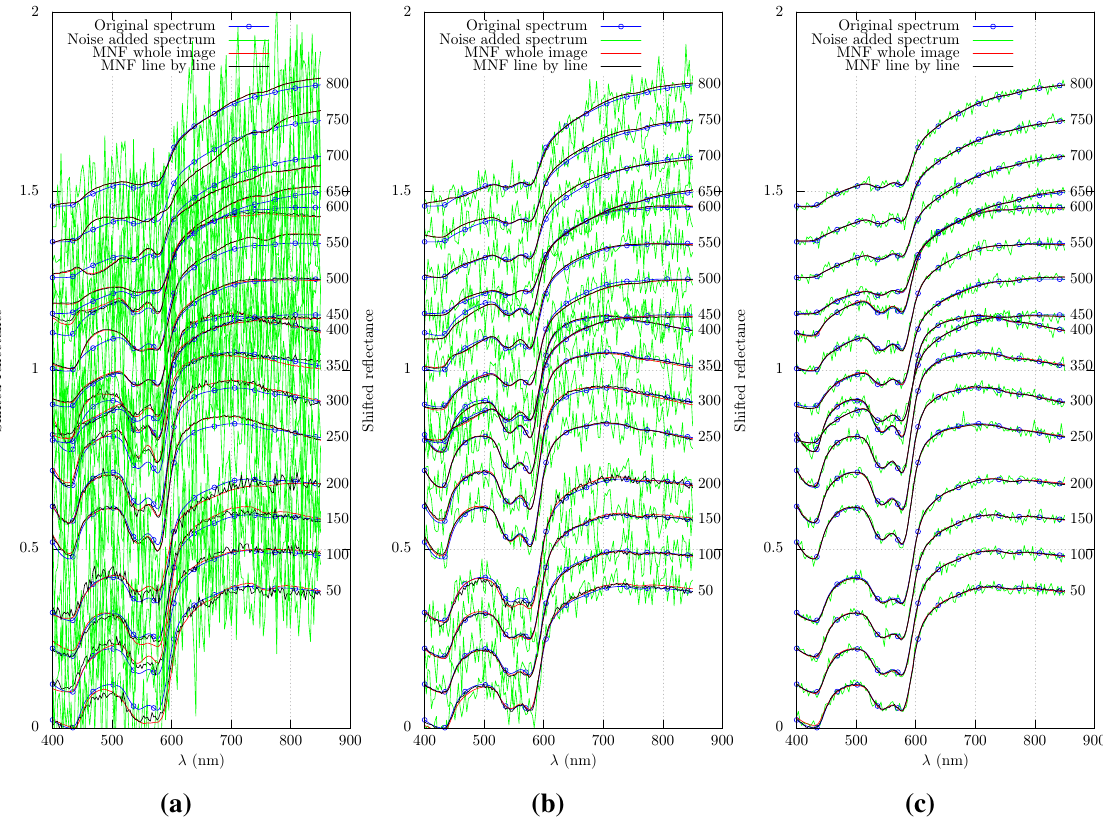
Figure 3. Comparison of simulated and denoised spectra (along x = 750 ). Line numbers are shown to the right. ( a ) σ 2 = 0 . 01 ; ( b ) σ 2 = 0 . 001 ; ( c ) σ 2 = 0 . 0001 .